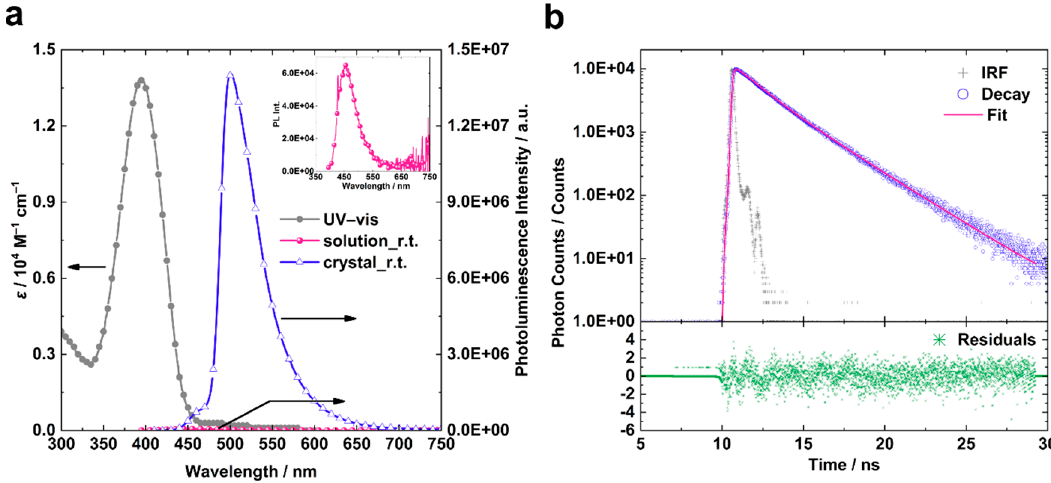
Figure 2. ( a ) UV–vis spectrum in 1 × 10 − 5 M 2-methylpentane/toluene (99/1, v / v ) solution (gray, – ● –), and photoluminescence spectra in the solution (magenta, – ○ –) and in the crystalline states (blue, – ∆ –). Inset shows an enlarged view of the photoluminescence spectrum in the solution state (magenta, – ○ –). ( b ) A photoluminescence decay curve (blue, ○ ) in the crystalline state at room temperature is shown with an instrument response function (gray, +), an exponential fitting curve (magenta, − ), and residuals of the fitting (green, ×). Table 2. Photophysical properties of LAlH at room temperature.